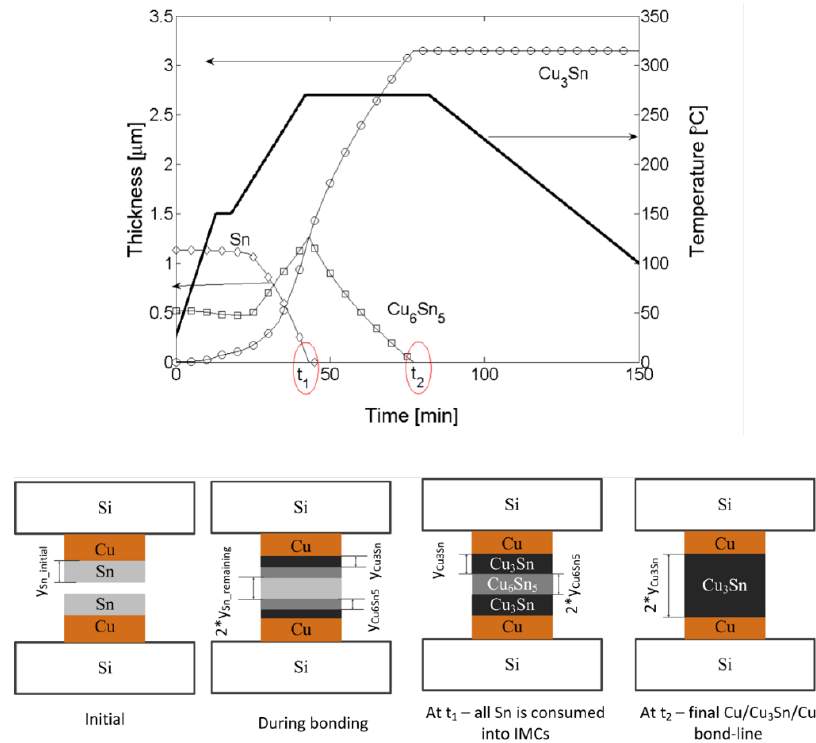
Figure 11. Example output of the copper-tin (Cu-Sn) solid-liquid interdiffusion (SLID) bonding model. Input variables include the temperature profile and thickness of metal layers. In this case, the model predicts that it will take less than 50 min to consume the Sn and roughly 75 min to convert the Cu 6 Sn 5 into the Cu 3 Sn [110–112]. Reprinted with permission from Dr. Thi Thuy Luu.